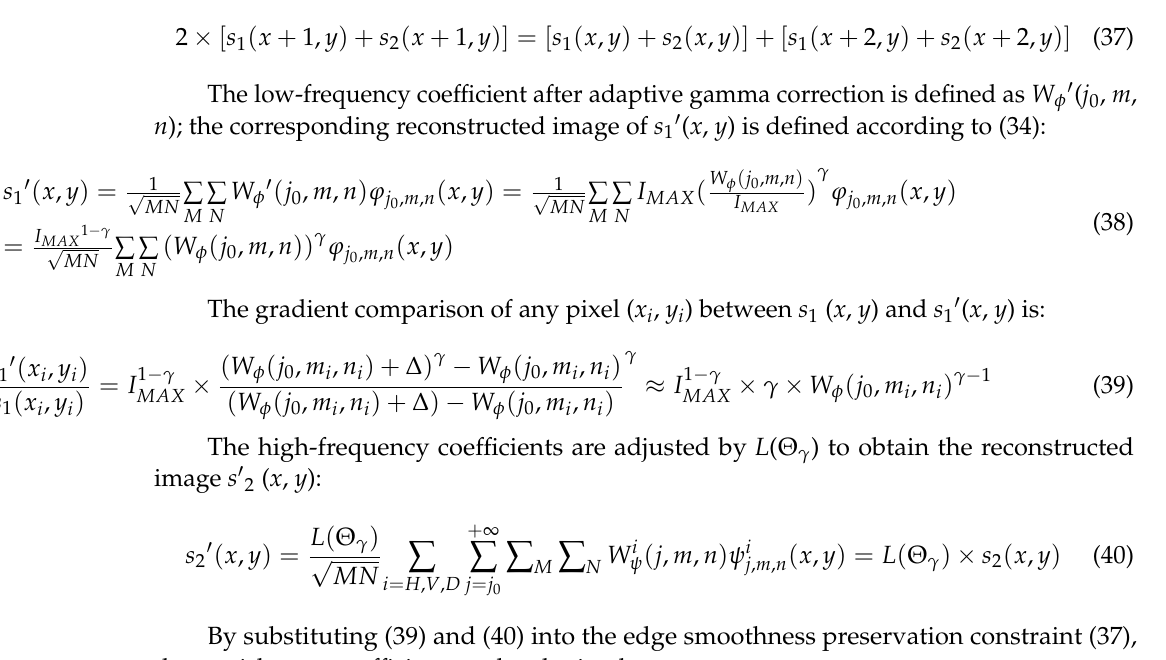
ς ( , ) x y , s 1 ( x , y ), s 2 ( x , y ).